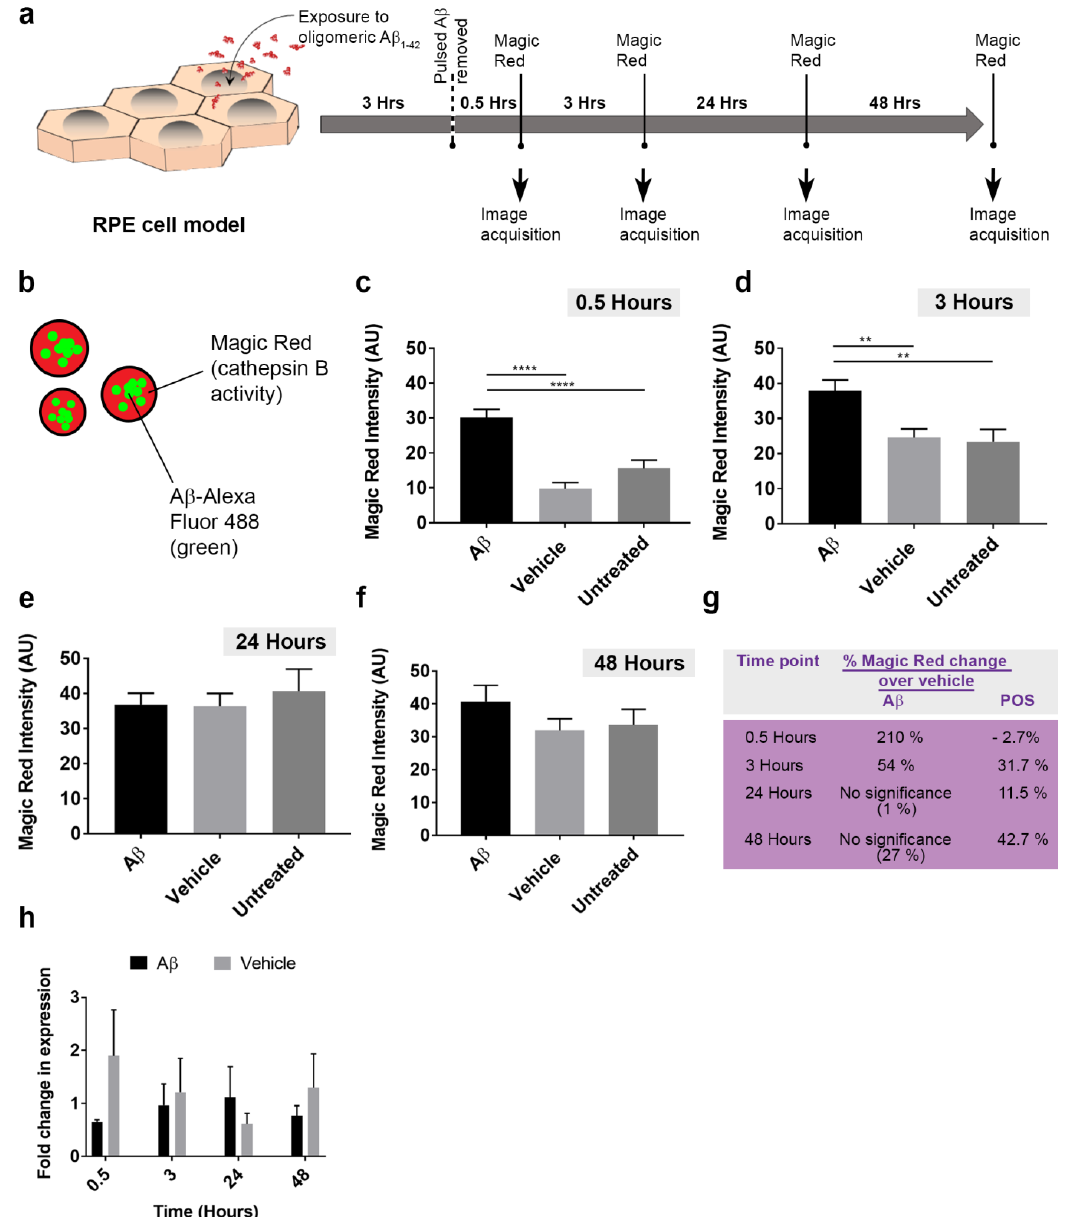
Figure 7. The cellular response to Aβ cargos in RPE lysosomes and transcriptional assessment of cathepsin B activity. ( a ) Schematic showing experimental plan where cultured RPE were exposed to 1 μM oligomeric Aβ 1-42 for 3 h, following the removal of which Magic Red was used to obtain readouts of lysosomal cathepsin B activity at different time points. ( b ) Schematic showing arrangement of fluorophores in experiment where Aβ-Alexa Fluor 488 (green) and Magic Red (cathepsin B enzymatic activity) can be simultaneously quantified. Time course showing intensity of Magic Red fluorescence at ( c ) 0.5 h, ( d ) 3 h, ( e ) 24 h and ( f ) 48 h following exposure to A β , vehicle or untreated controls. Significant differences were observed in Magic Red intensity between A β vs. vehicle-treated controls as well as untreated sister cultures at 0.5 and 3 h, which diminished thereafter to baseline levels. n = 40 for A β 1-42 , vehicle and n = 30 for untreated cultures across four biological replicates (10 images analyzed per treatment/experiment). Kruskal–Wallis with Dunn’s multiple comparisons where ** denotes a significance of p < 0.01, whilst **** indicate p < 0.0001. ( g ) A summary table showing Magic Red activity in response to A β cargo as a percentage change over vehicle, compared to responses for POS cargo. ( h ) Quantitative PCR analysis of cathepsin B (CSTB) mRNA expression in relation to the EIF4A2 reference gene as fold change in expression, n = 3. No significant differences in cathepsin B mRNA levels were detected between A β -treated vs. vehicle or untreated